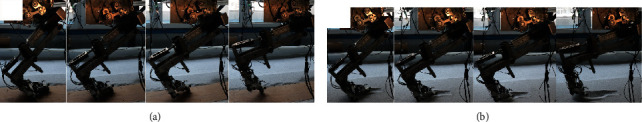
The travelling process of the bionic mechanical foot. (a) Travelling process on solid ground. (b) Travelling process on loose sand.